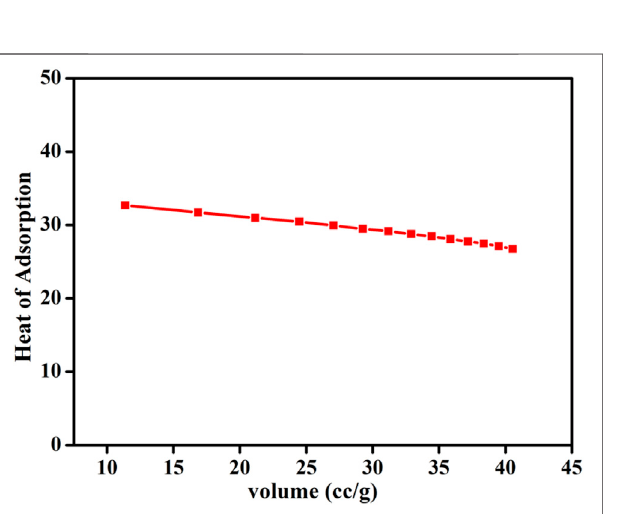
Frontiers in Chemistry |